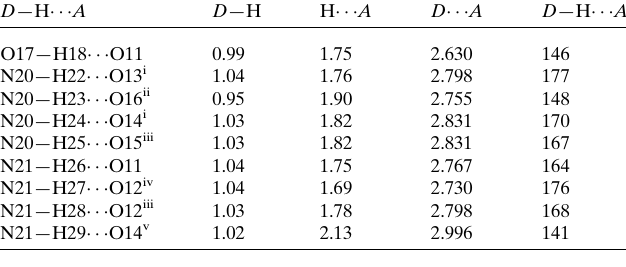
Table 2 Hydrogen-bond geometry (A˚ , (cid:3) ) for (II) (DFT). D —H (cid:2)(cid:2)(cid:2) A